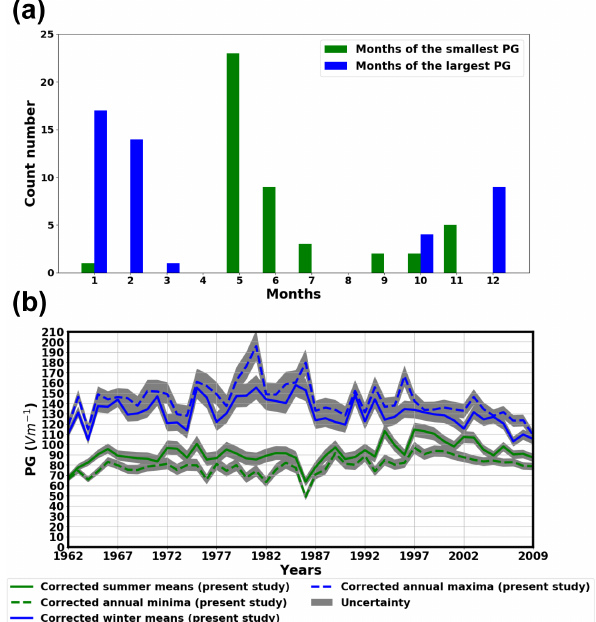
Figure 7. (a) The number of months with the annual greatest or smallest PG monthly mean value between 1962 and 2009. (b) Com- parison of the annual minima/maxima and summer/winter means PG time